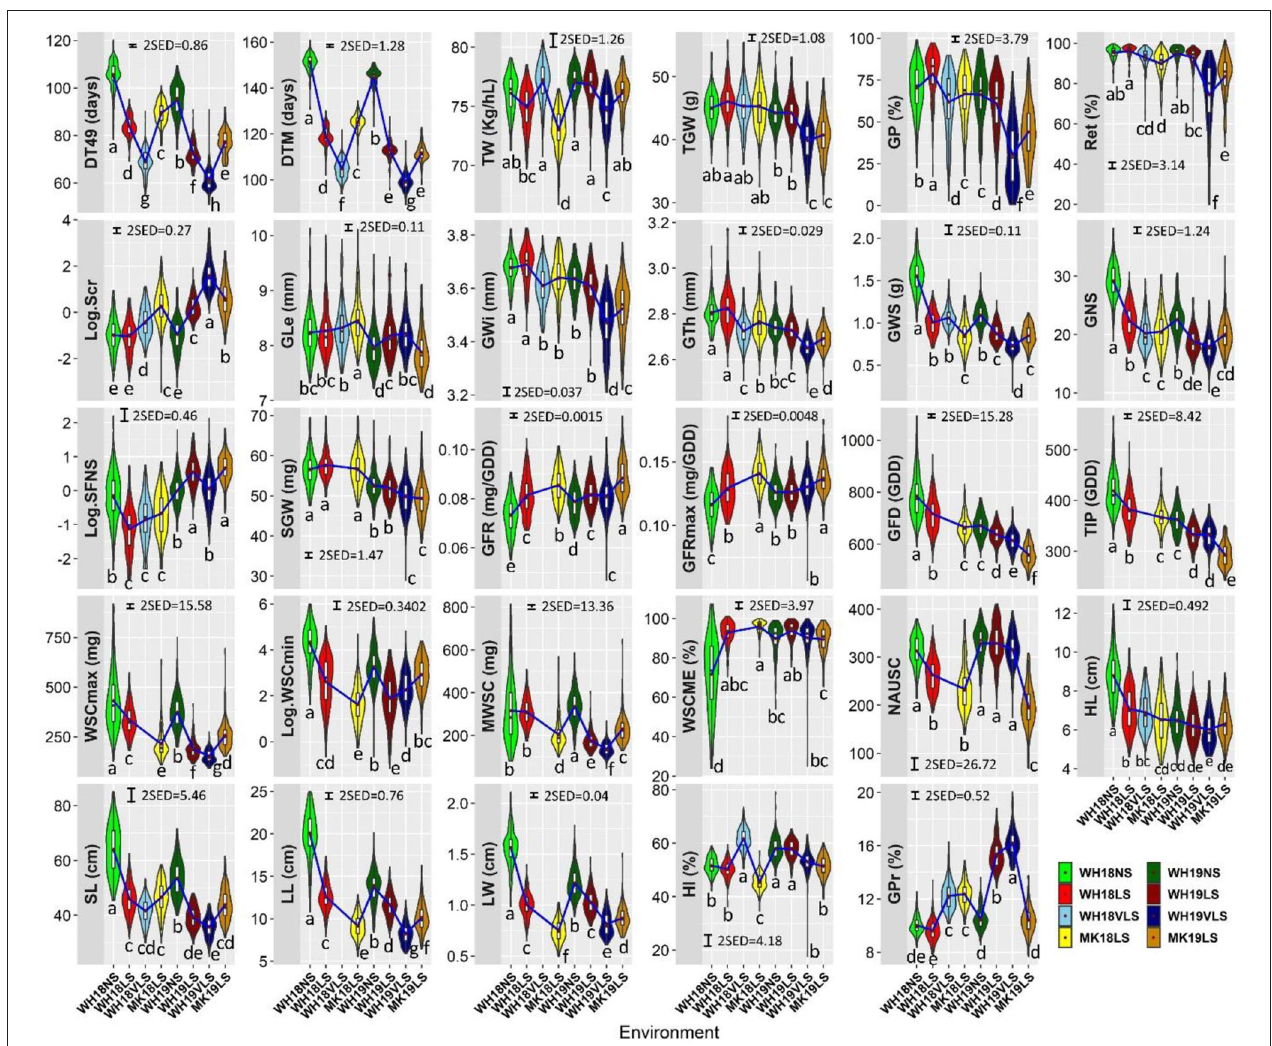
FIGURE 2 | Trait distributions in WH18NS (light green), WH18LS (light red), WH18VLS (sky blue), MK18LS (yellow), WH19NS (dark green), WH19LS (dark red), WH19VLS (navy blue), and MK19LS (orange) environments. The length of the boxes show the interquartile range, the horizontal line within the box indicating the median, red diamonds within the box representing the mean, the whiskers the variability within 1.5 interquartile range of the upper and lower quartiles, and the widths of the violin plots indicate the probability density of the data at different values. The blue lines connect the means of each environment for each trait. Environment and trait definitions are as defined for Tables 1 , 2 , respectively. Bars represent 2 × standard error of differences (SED) with α = 0.05. Different letters below the violin plots represent significant differences between environments for each trait at significance level of 0.05.